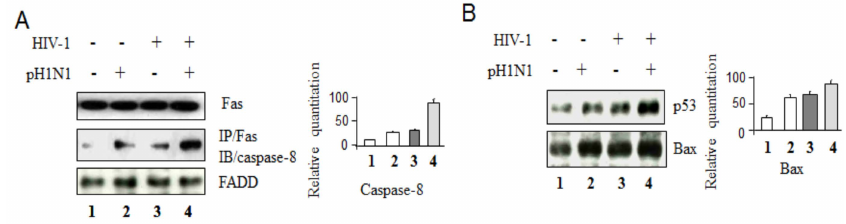
Figure 2. Pandemic influenza A (H1N1) virus infection can induce more intense activation of apoptotic pathways in HIV-1 infected cells. Jurkat cells were infected with/without HIV-1 (MN) for 3 days, and then infected with pH1N1, stock A/California/04/2009, and cultured for 3 days. The cell lysates were subjected to Western blot analysis to detect FADD ( A ), p53 and Bax ( B ), with Fas (A) and GAPDH (B) as the standard loading control. DISC formation was evaluated by immunoprecipitation (IP) total lysates with anti-Fas antibody followed by immunoblotting (IB) to detect caspase-8 (A). These data indicate that pandemic influenza A (H1N1) infection can induce both Fas-mediated